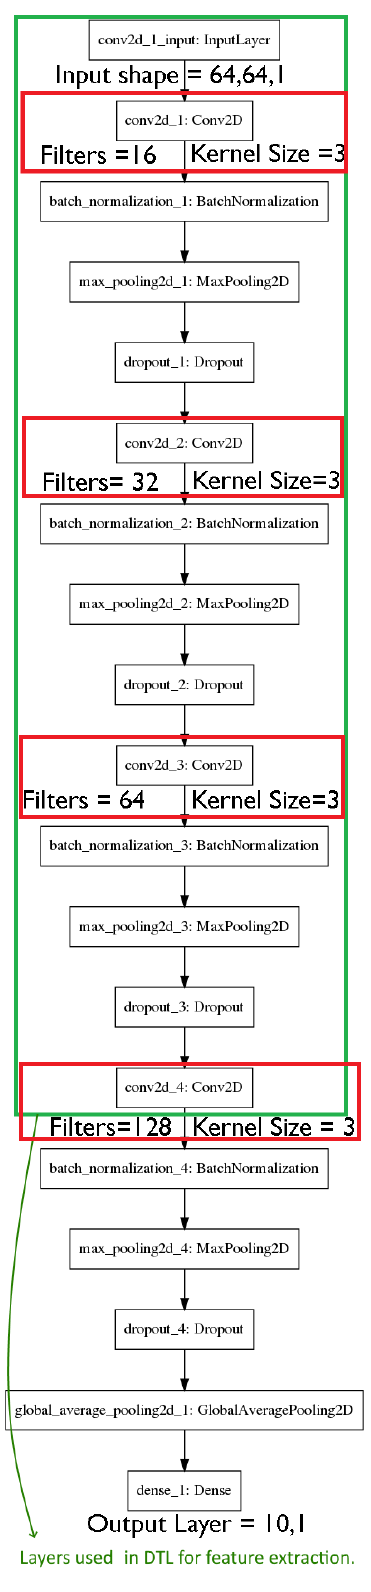
Figure 8. The CNN architecture is shown. The layers in the green rectangle are used for feature extraction in DTL. In order to train a model for local data, all layers are used. Conv2D stands for 2D Convolutional